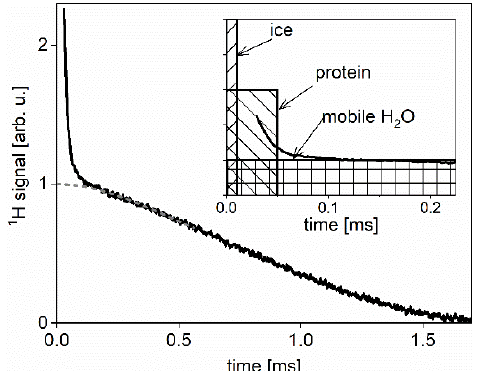
Figure A1. Illustration of the method applied to measure the fraction of the mobile water component. The slowly decaying part of the FID signal is extrapolated to t = 0 (by a stretched exponential, gives narrow spectrum line). The extrapolated signal intensity is normalized to the signal intensity measured above 0 ◦ C where the whole sample is in liquid state. Inset: typical time-spreads of FID signal components produced by 1 H nuclei in ice, in protein and in mobile water. The FID component originating from the ice-phase protons decays to zero at ~50 µ s. The protein protons provide a signal observable as less wide than 100 µ s at half of its maximum amplitude. The component with a full width at half maximum greater than 100 µ s at ( − 50)–( − 40) ◦ C and widening further into millisecond regions as the temperature increases, that component belongs to mobile (hydration) water phase.